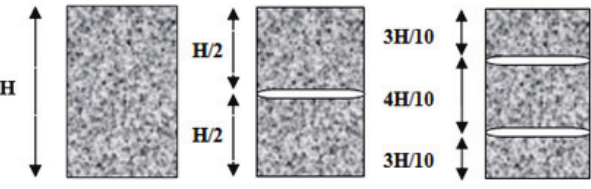
Fig. 4. Layers arrangement of geotextile on sand samples